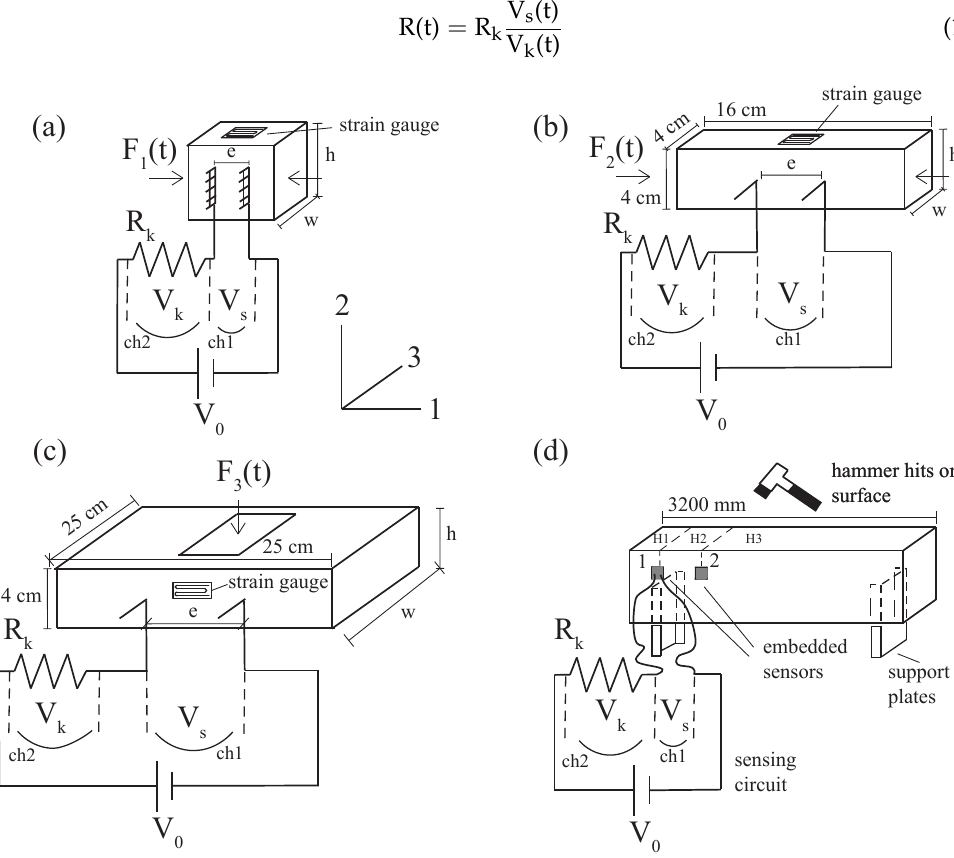
Figure 6. The setups and related electrical circuits: ( a ) the typical cube sample; ( b ) the beam sample; ( c ) the plate sample; and ( d ) the full-scale beam with embedded smart concrete sensors plotted together with